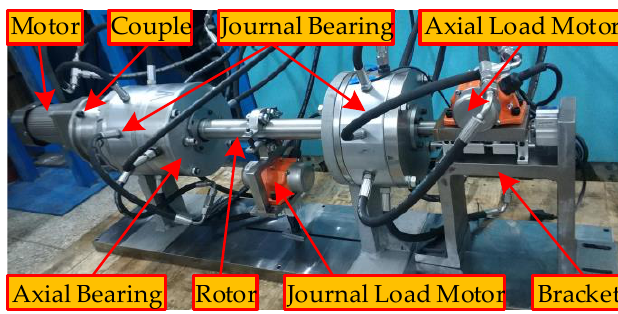
Figure 2. Experimental Table of Magnetic-Liquid Double Suspension Bearing (MLDSB).